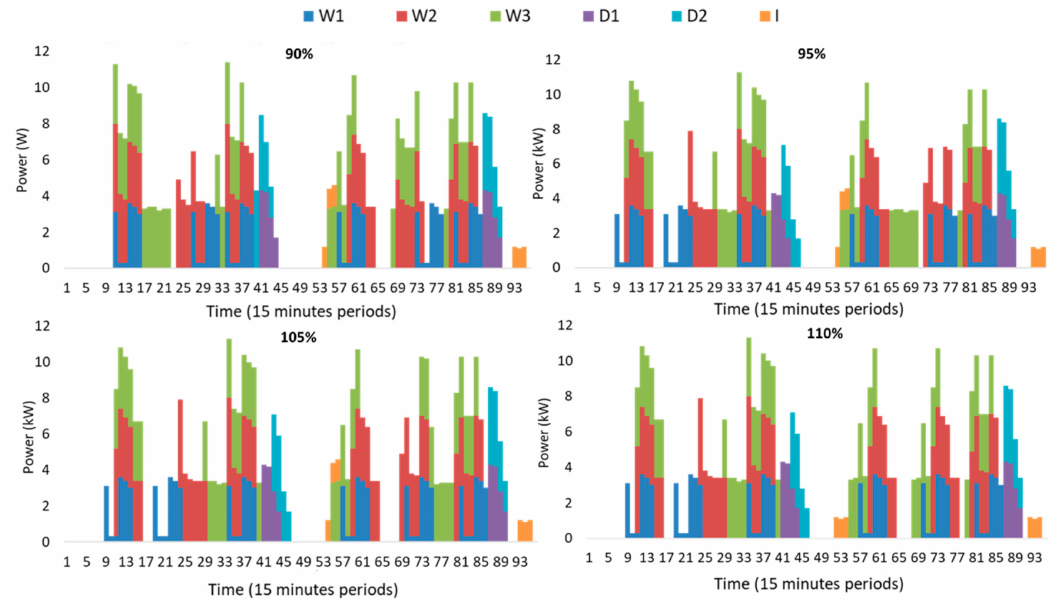
Figure 7. Power consumption of devices regarding sensitivity analysis of power consumption limit.